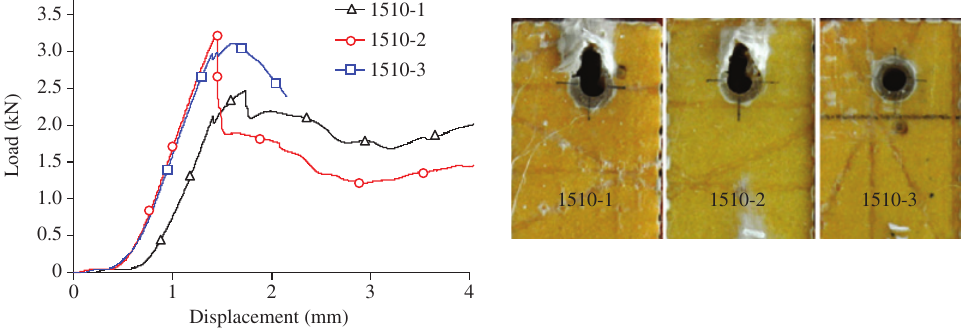
Figure 8 Load-displacement variations and images of the damaged samples for E = 15 mm and D = 10 mm.